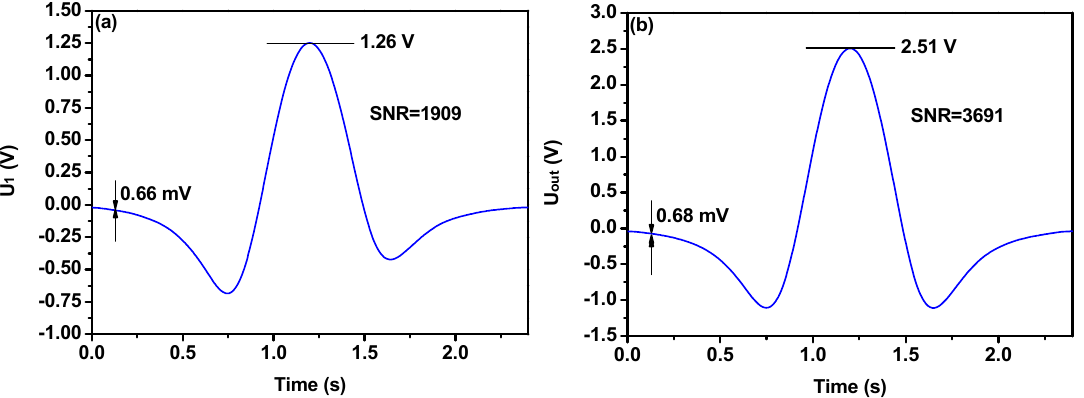
Figure 4. Experimental result. ( a ) The diagram of second harmonic signal when DFB-LD1 and lock-in amplifier 1 works alone, ( b ) The diagram of second harmonic signal in dual path lock-in system.